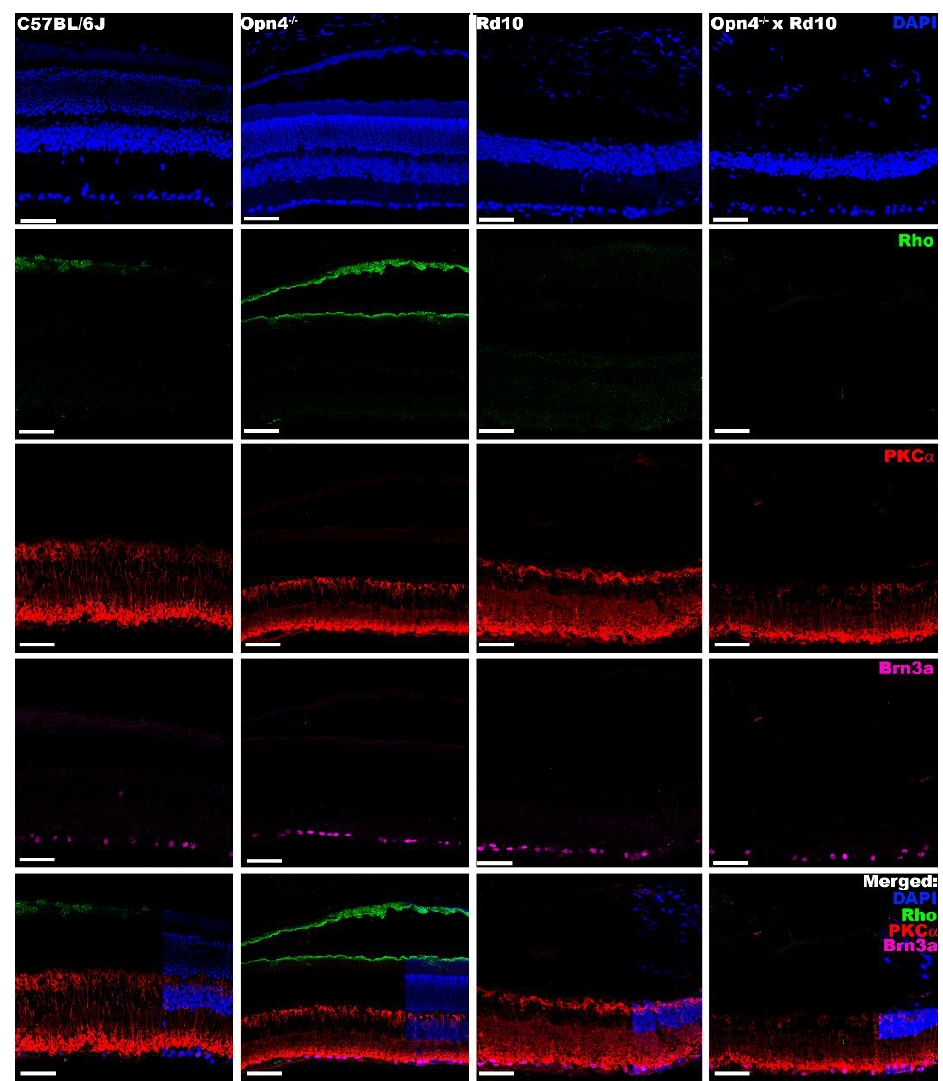
Figure 8. Immunohistochemical labeling of external segment of rods, rod bipolar cells, and RGCs. From left to right, the different animal models are presented (C57BL/6J; Opn4 − / − ; Rd10; Opn4 − / − × Rd10). From top to bottom, the different agents and antibodies used are presented. DAPI : intercalating marker of cell nuclei; Rhodopsin (Rho) : opsin located in the outer segments of the rods ; PKC α : bipolar cell structural marker; Brn3a : protein located in the ganglion cells of the retina. The bottom row shows “ Merged ” of different labelings. As can be seen, in the models that present photoreceptor degeneration (rd), the marking of the outer segments of the photoreceptors disappears, while the cells of the inner retina show no apparent differences in any of the four animal models. The scale bar indicates 50 µm.